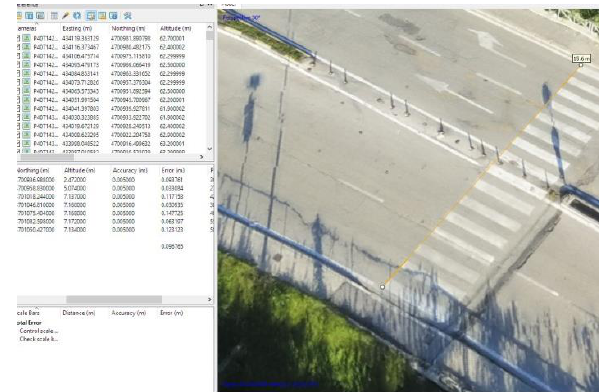
Figure 12: the table allows us to define the error accumulated in the area with respect to the verification